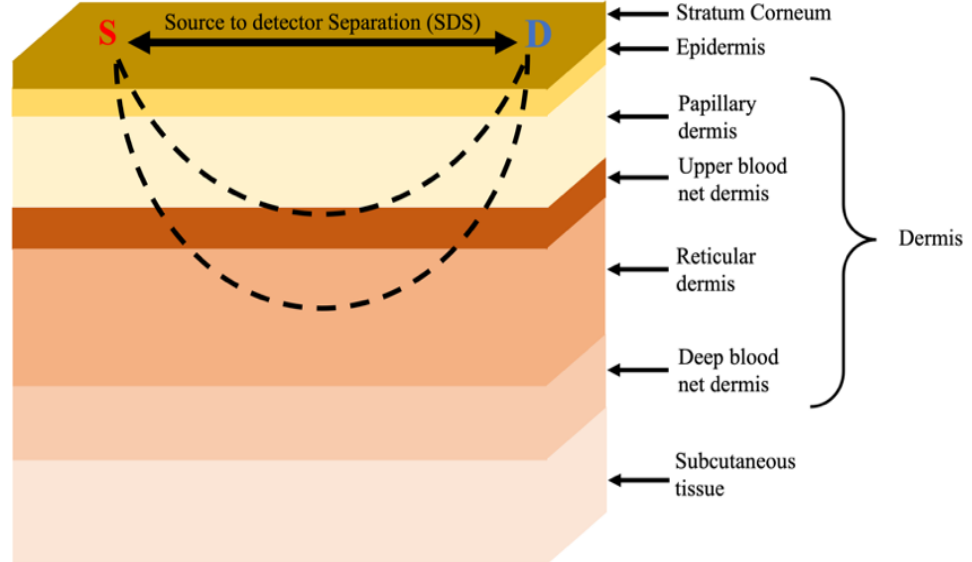
Figure 1. Schematic drawing of the skin model for Monte Carlo simulation. The light propagation distribution, having a “banana shape”, is illustrated by the dashed lines between the source (S) and the detector (D).